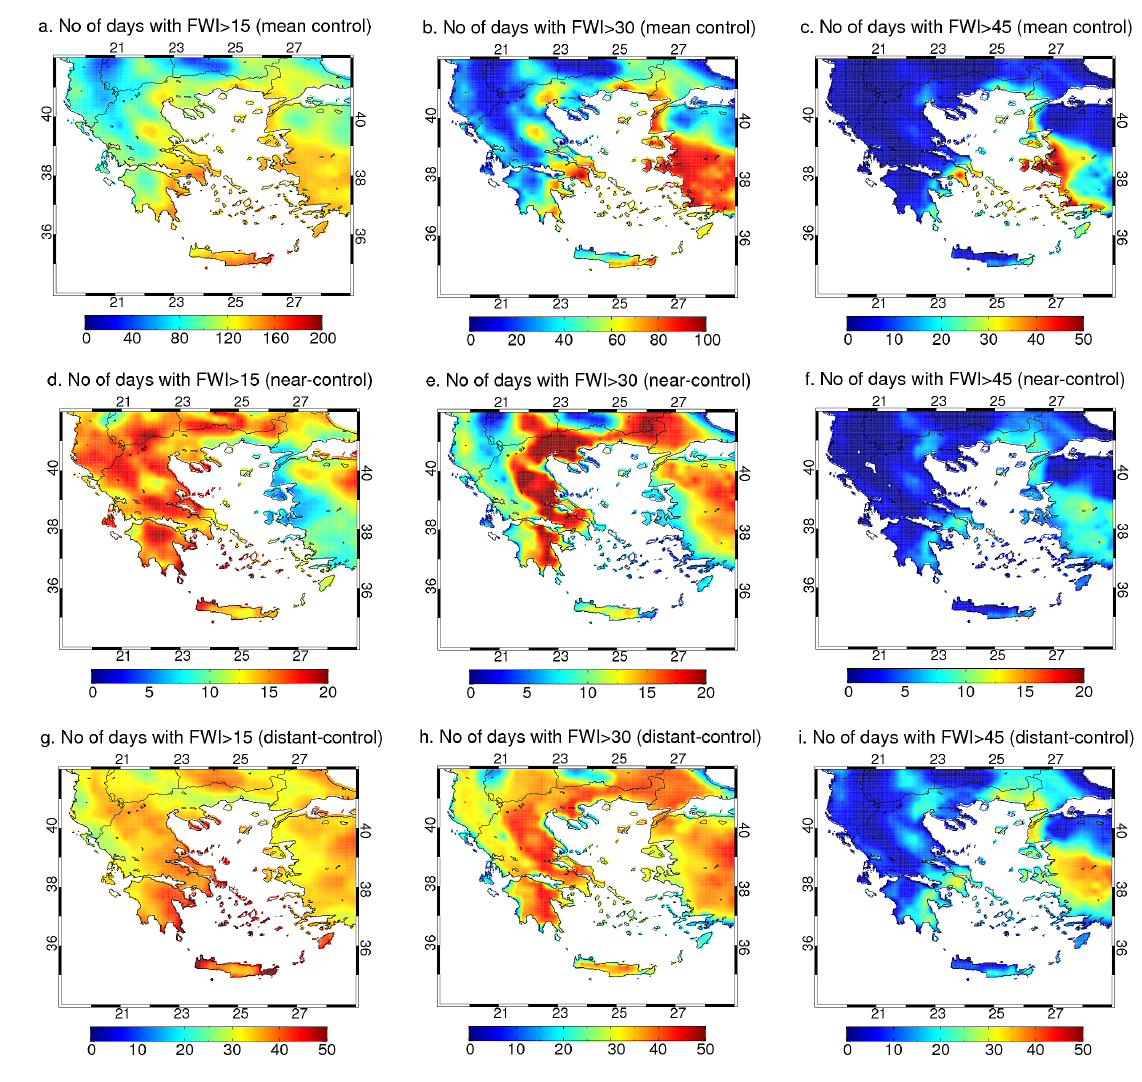
Fig. 5. (a, b, c) Mean number of critical fire risk days for the control period (1961–1990), (d, e, f) differences between the near future (2021– 2050) and the control period, and (g, h, i) differences between the distant future (2071–2100) and the control period. Columns correspond to different subregions: (a, d, g) WG, (b, e, h) NG and (c, f, i)